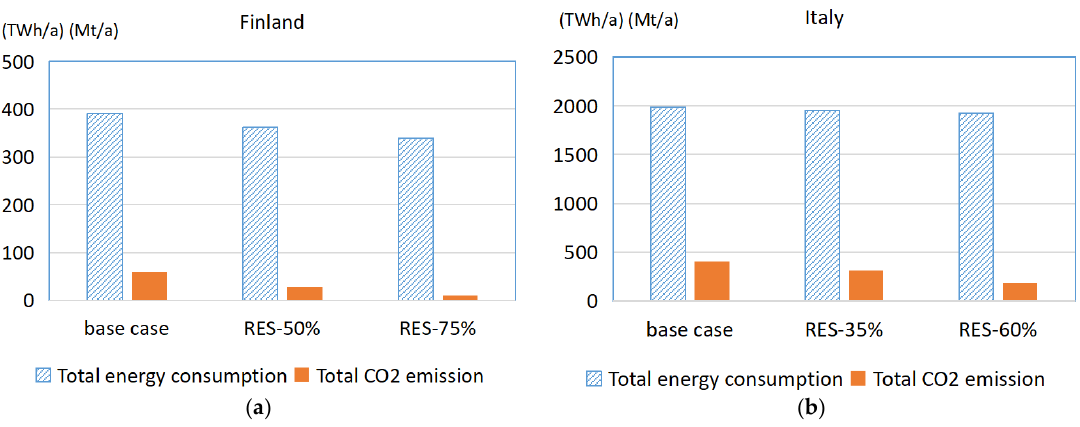
Figure 25. Modeled total energy consumption and CO 2 emission for ( a ) Finland and ( b ) Italy.